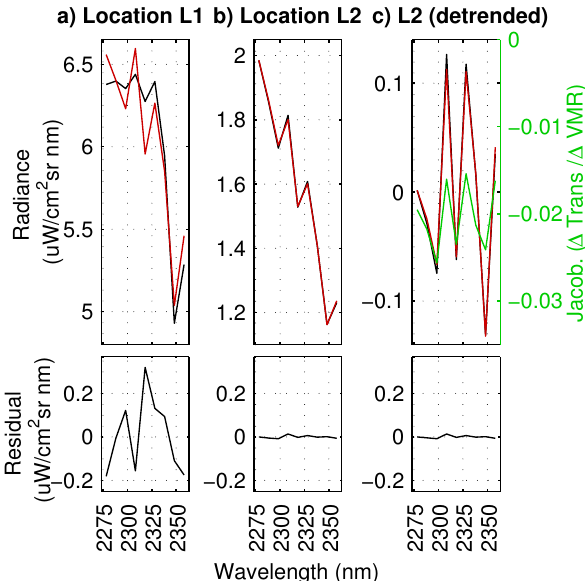
Fig. 9. (a) Radiance at 2278nm, showing a portion of the Ingle- wood Oil Field. (b) For the same image subset, CH 4 scaling factor for the lowest atmospheric layer (layer 10) appears heavily influ- enced by land surface type. (c) Standard deviation of the residu- als also appears influenced by land cover. (d) Subcolumn XCH 4 (ppmCH 4 for the lowest layer), excluding dark pixels (less than 0.1uWcm − 2 sr − 1 nm − 1 in the fitting window). (e) Close-up of hy- drocarbon storage tanks upwind of observed plume (Google Earth,